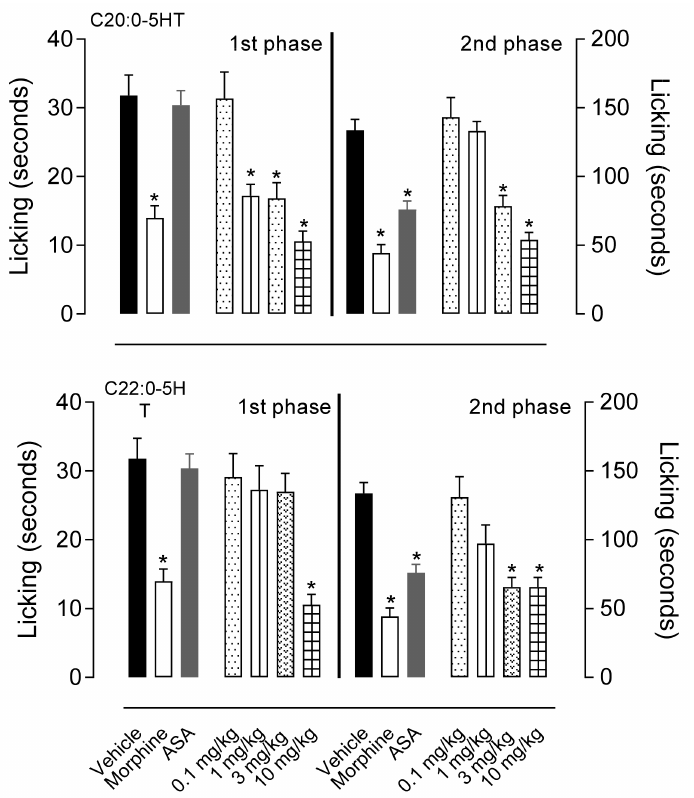
Figure 2. Effects of β N -arachinoyl-5-hydroxytryptamide (C 20:0 -5HT) and β N -behenoyl-5- hydroxytryptamide (C 22:0 -5HT) on formalin-induced licking behavior in mice. Animals were pretreated orally with C 20:0 -5HT or C 22:0 -5HT, morphine (5 mg/kg), acetylsalicylic acid (ASA, 200 mg/kg), or vehicle, and the time of licking the formalin-injected paw was recorded (in sec- onds) at the first phase (0–15 min post-formalin injection) and second phase (15–30 min post-formalin injection). The results are presented as mean ± SD ( n = 7 animals per group). The average in the morphine groups was significantly decreased as compared with the respective vehicle group to each phase (first or second phase). All three doses of C 20:0 -5HT significantly reduced the licking time in the 1st phase and the two higher doses of the same compound reduced it in the 2nd phase. The dose of 10 mg/kg of C 22:0 -5HT significantly reduced the licking time in the 1st phase and the two higher doses of the compound reduced it in the 2nd phase. ASA was decreased as compared with the vehicle group in the 2nd phase only. Statistical significance was calculated by one-way ANOVA followed by Tukey’s test. * p < 0.05 as compared with vehicle-treated